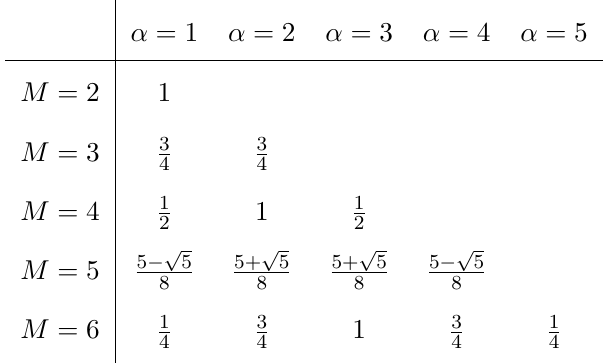
Table 1 : The first few values of s